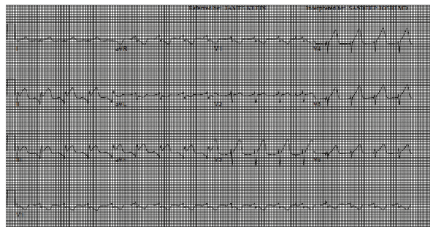
Figure 2: Post-CABG EKG showing ST segment elevations in L-II, L-III, aVF, and V3–V6.